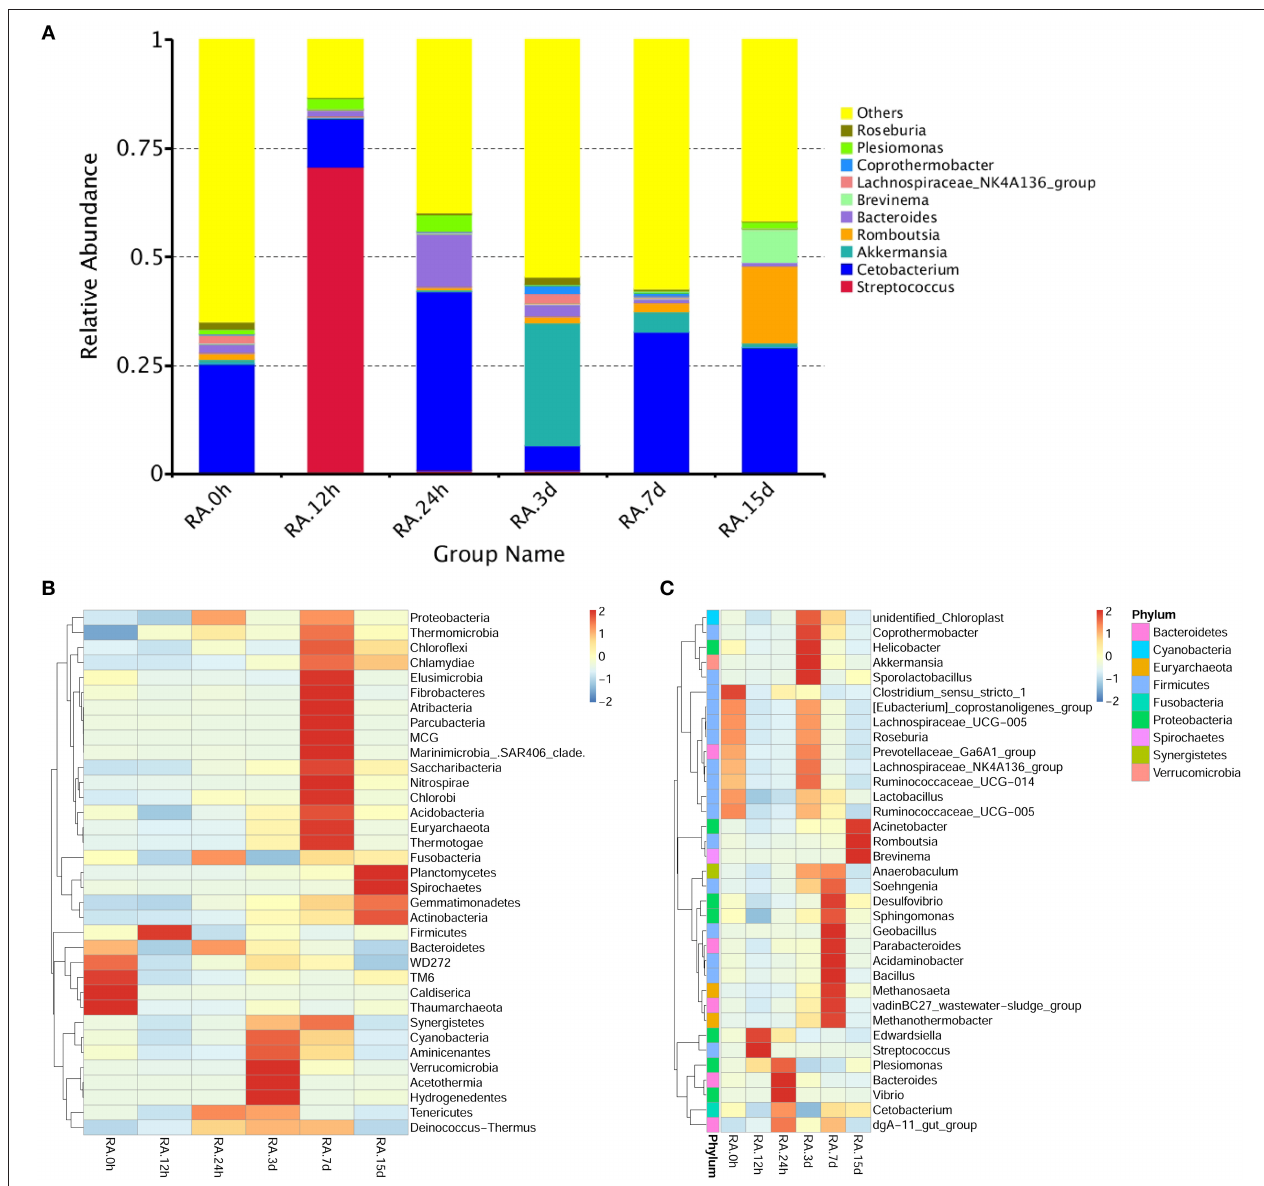
FIGURE 4 | YM001 alters the intestinal flora composition at different observing times. (A) The relative abundances of the top 10 bacteria at the genus level in YM001 groups. (B) The alteration of intestinal bacterial patterns at the genus level. The heat map is color-based on row Z-scores. The highest and lowest bacterial levels are showed in red and blue, respectively. (C) The alteration of intestinal bacterial patterns at the phylum level. The heat map is color-based on row Z-scores. The highest and lowest bacterial levels are showed in red and blue, respectively.